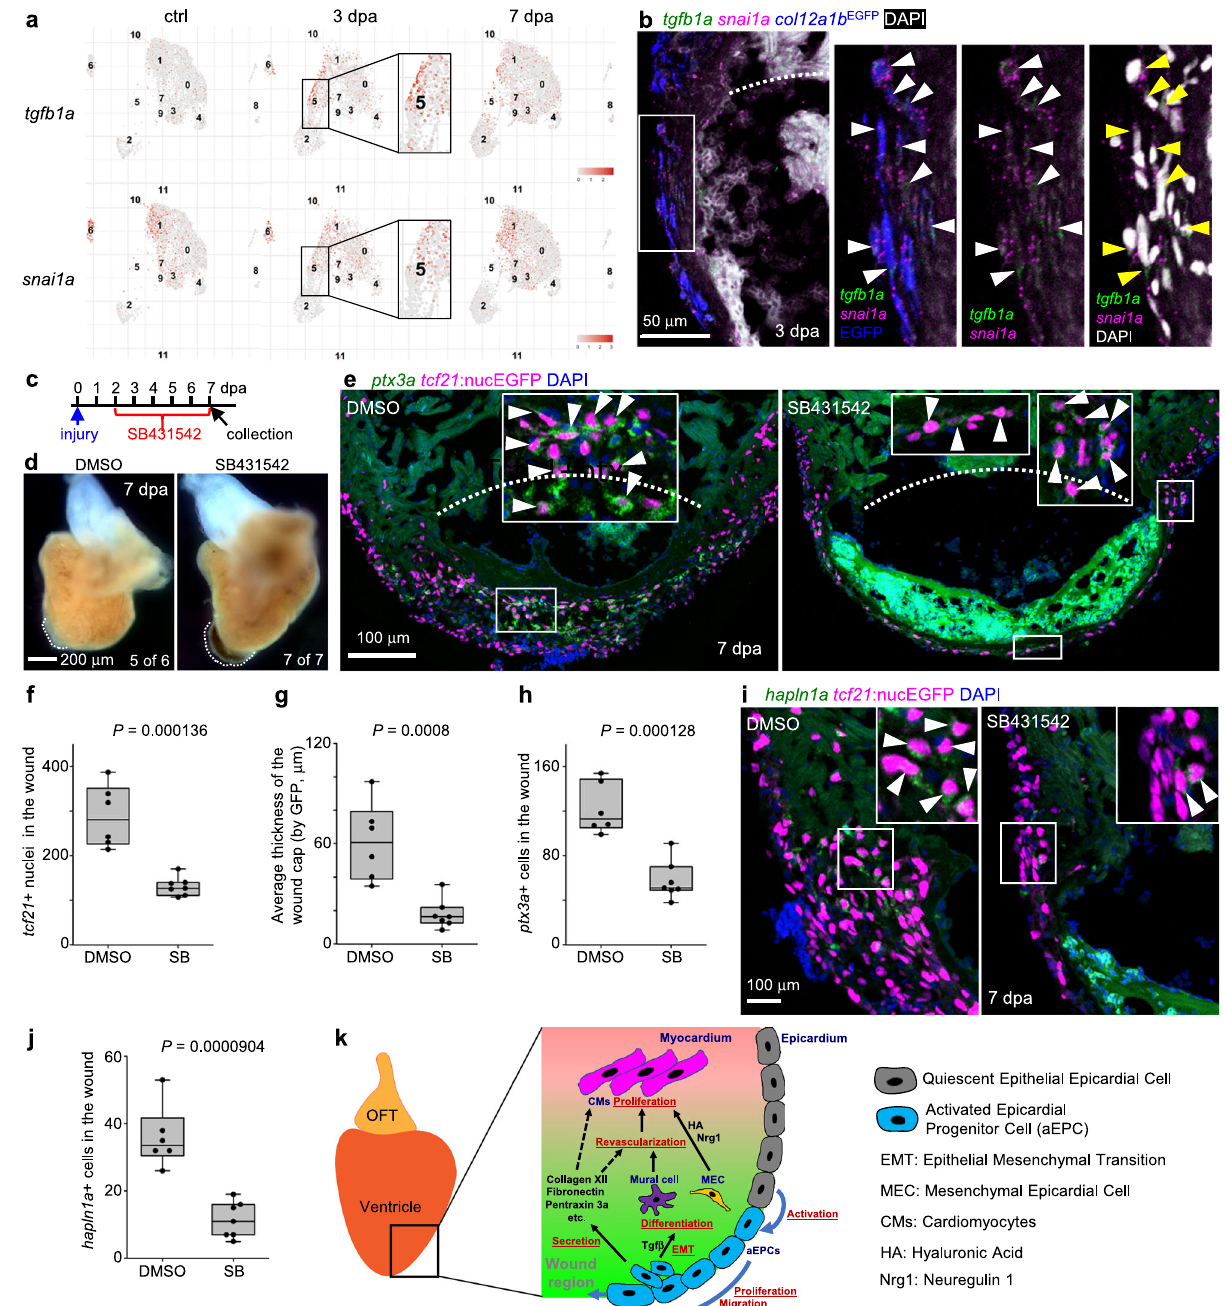
Fig. 9 | Tgf β signaling regulates aEPC EMT and differentiation. a UMAPs showing tgfb1a and snai1a expression across samples. The aEPC population (cluster5)ishighlightedinframes. b SectionimagesoftheinjurysiteshowingHCR staining signals of tgfb1a and snai1a at 3dpa in green and magenta, respectively. col12a1b EGFP is shown in blue. The white dash line denotes the injury site. The framed region is enlarged to show details on the right with different channel combinations. DAPI staining is shown in white in the last panel. Arrowheads indi- cate representative tgfb1a + snai1a + EGFP + cells. c Experimental design for SB431542 treatment. d Whole-mount images of hearts collected at 7dpa. Dash lines denote the injury sites. Large blood clot and extra tissue were observed in SB431542- treated hearts (7 of 7), but not in those from the DMSO-treated fi sh (5 of 6). Scale bar,200 μ m. e Sectionimagesofinjuredventriclesat7dpa.Theepicardialcellsare labeled with tcf21: nucEGFP (magenta) and HCR staining signals of ptx3a in green. Nuclei were stained with DAPI (blue). White dashed lines indicate the injury sites. The framed regions are enlarged to show details with arrowheads indicating